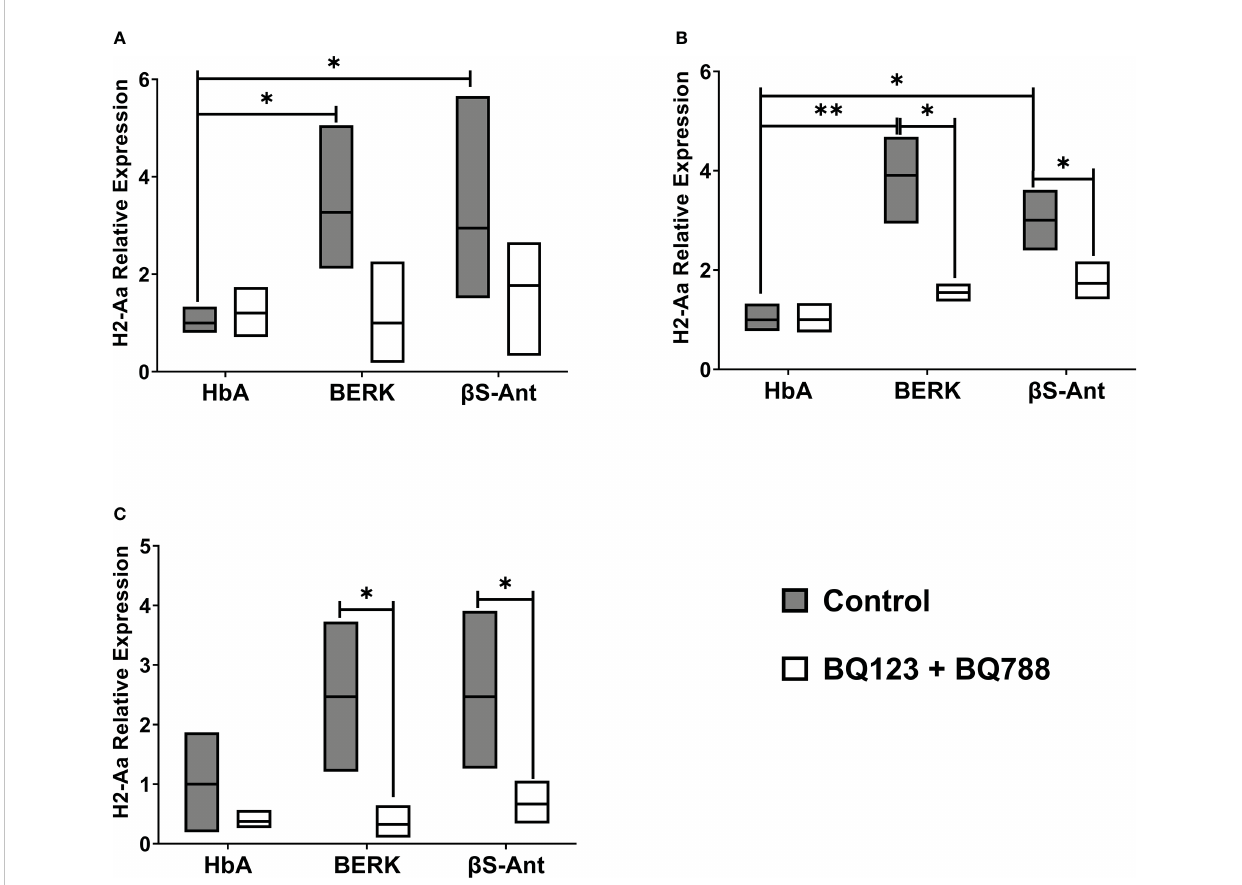
FIGURE 1 MHC mRNA levels are decreased by in vivo treatment with ET-1 receptor antagonists in Sickle Transgenic Mice. MHC class II gene, H2-Aa, was measured in the spleen (A) , lung (B) , and kidneys (C) from BERK, b S-Antilles ( b S-Ant) mice and mice expressing human HbA following treatment with or without Endothelin-1 receptor antagonist as described in Methods. Nox plot shows means, SE performed in duplicate in 9 HbA, 7 Berk, and 9 b S- Antilles mice; *p < 0.05, **p <